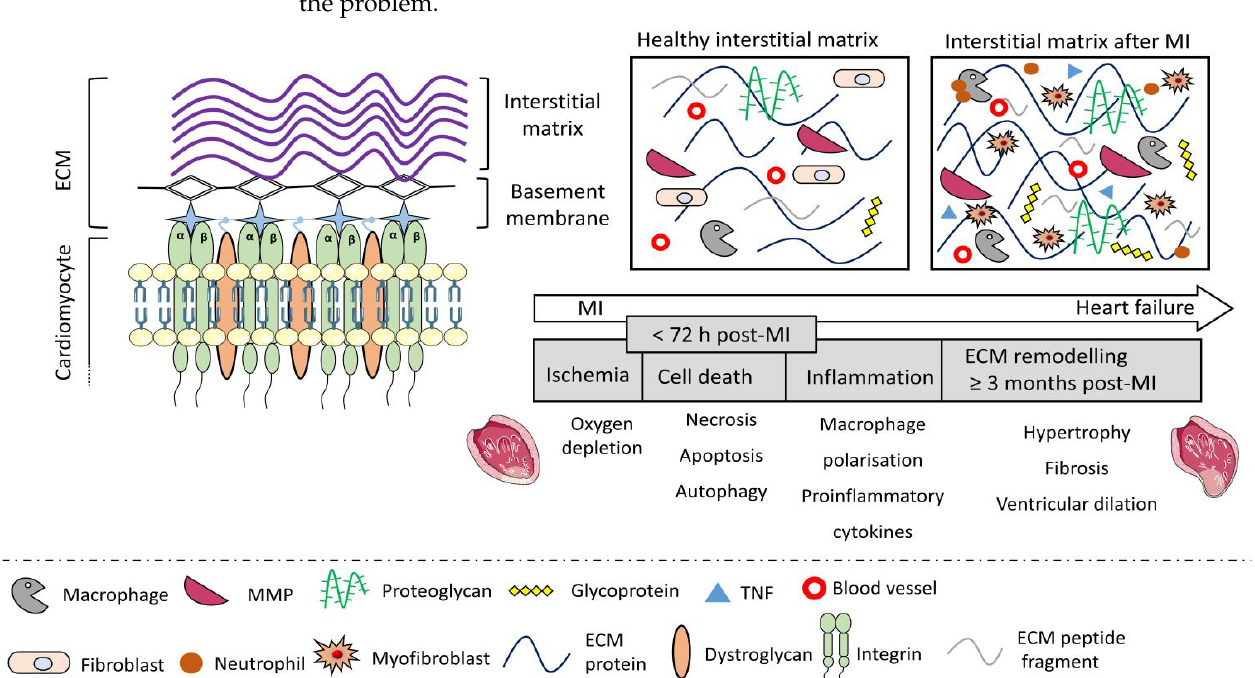
Figure 5. ECM components: Interstitial matrix consists of fibrillar collagen, elastin, proteoglycans, and glycoproteins; basement membrane is made of non-fibrillar collagen and laminin. Cardiomyocytes attach to the basement membrane via transmembrane proteins, such as integrin and dystroglycan. The excessive ECM secretion after the infarction leads to tissue hypertrophy and scar for- mation preventing quick ventricular dilation and tissue rupture. Adapted from [14] under the CC- BY license.